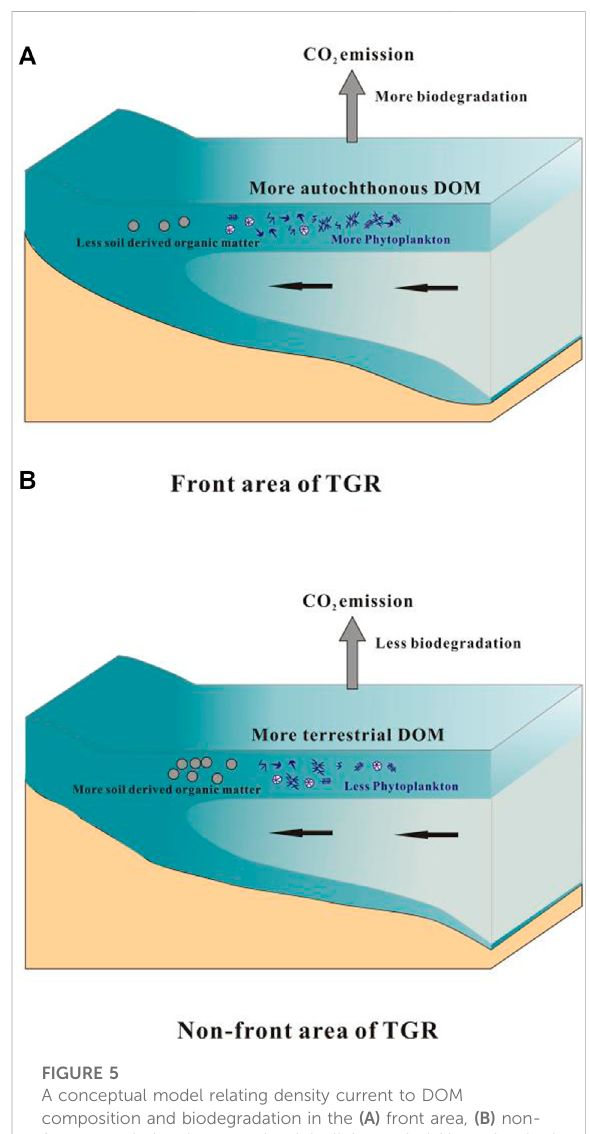
FIGURE 5 A conceptual model relating density current to DOM composition and biodegradation in the (A) front area, (B) non- front area, during the water-level declining period. Note: river bed is only conceptual and arrows in conceptual model do not indicate accurate fl ow rate but fl ow direction